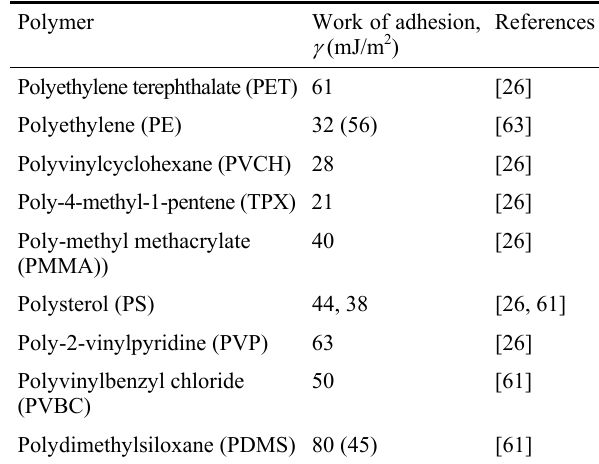
Table 2 Selected results on work of adhesion measured by means of